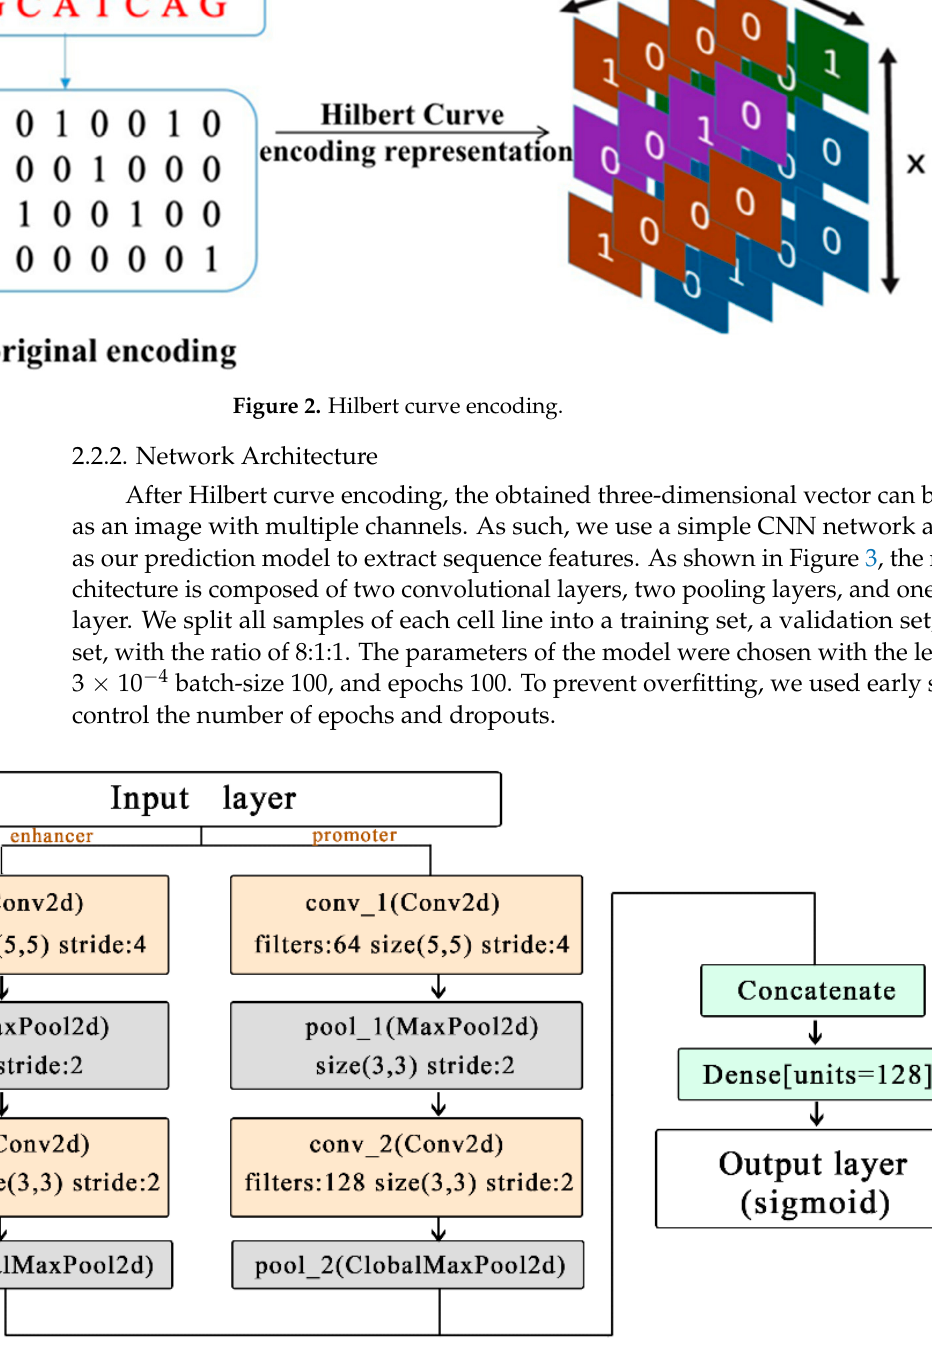
Figure 3. The relationship between Hilbert curve and EPIs.